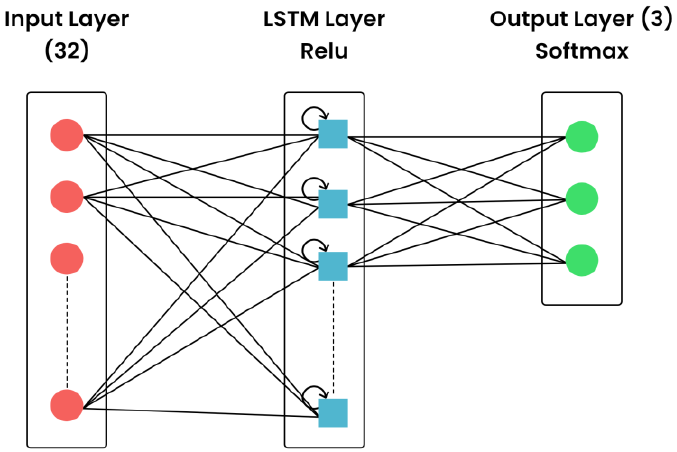
Figure 3. The probabilities of the instances of each class in LSTM (proposed).